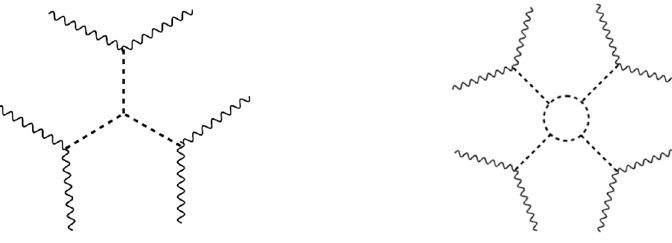
Figure 1 . Generating higher-curvature terms by integrating out φ with a gφ 3 interaction. Dashed lines are φ propagators, and external gravity lines represent insertions of the Weyl